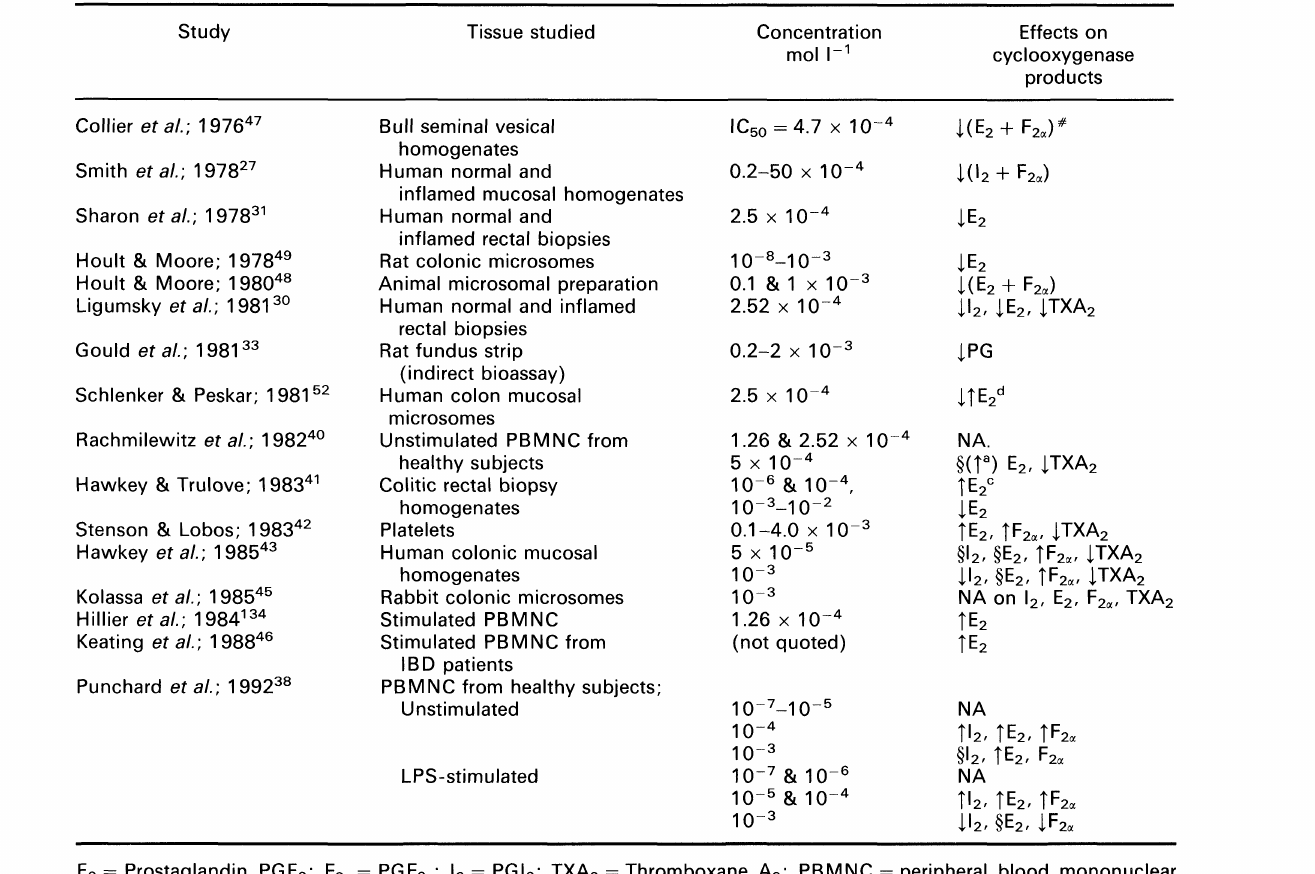
Table 1. In vitro studies of the effects of sulphasalazine on prostaglandin and thromboxane